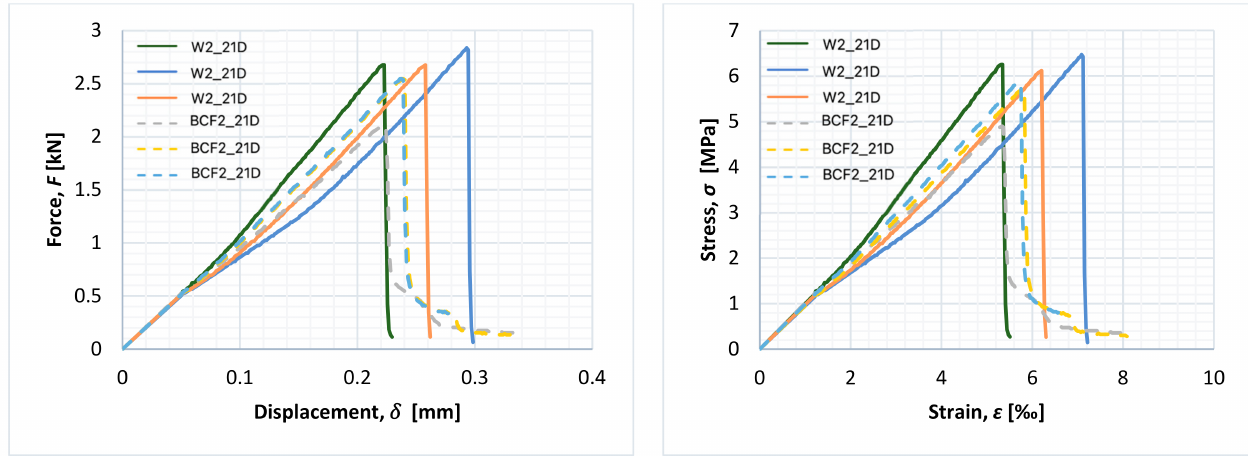
Figure 9. Force–displacement and stress–strain curves for the entire test duration for each specimen of series W2_21D (continuous line) and BCF2_21D (dashed